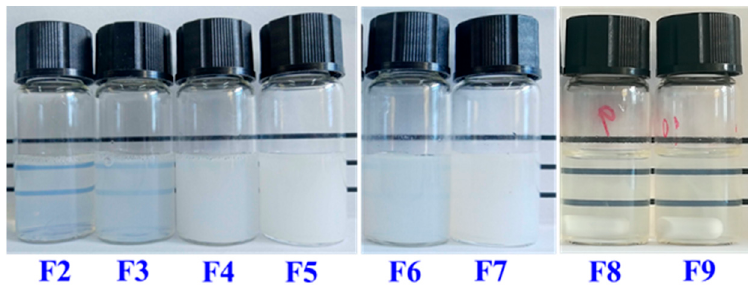
Figure 6. Appearance of freshly prepared glyceryl monostearate- (GMS-), 1,3-LP-, and glyceryl tripalmitate-solid lipid nanoparticle (PPP-SLN) dispersions. F2, F3, F4, F5, F6, F7, F8, and F9 represent the formulations in Table 1.